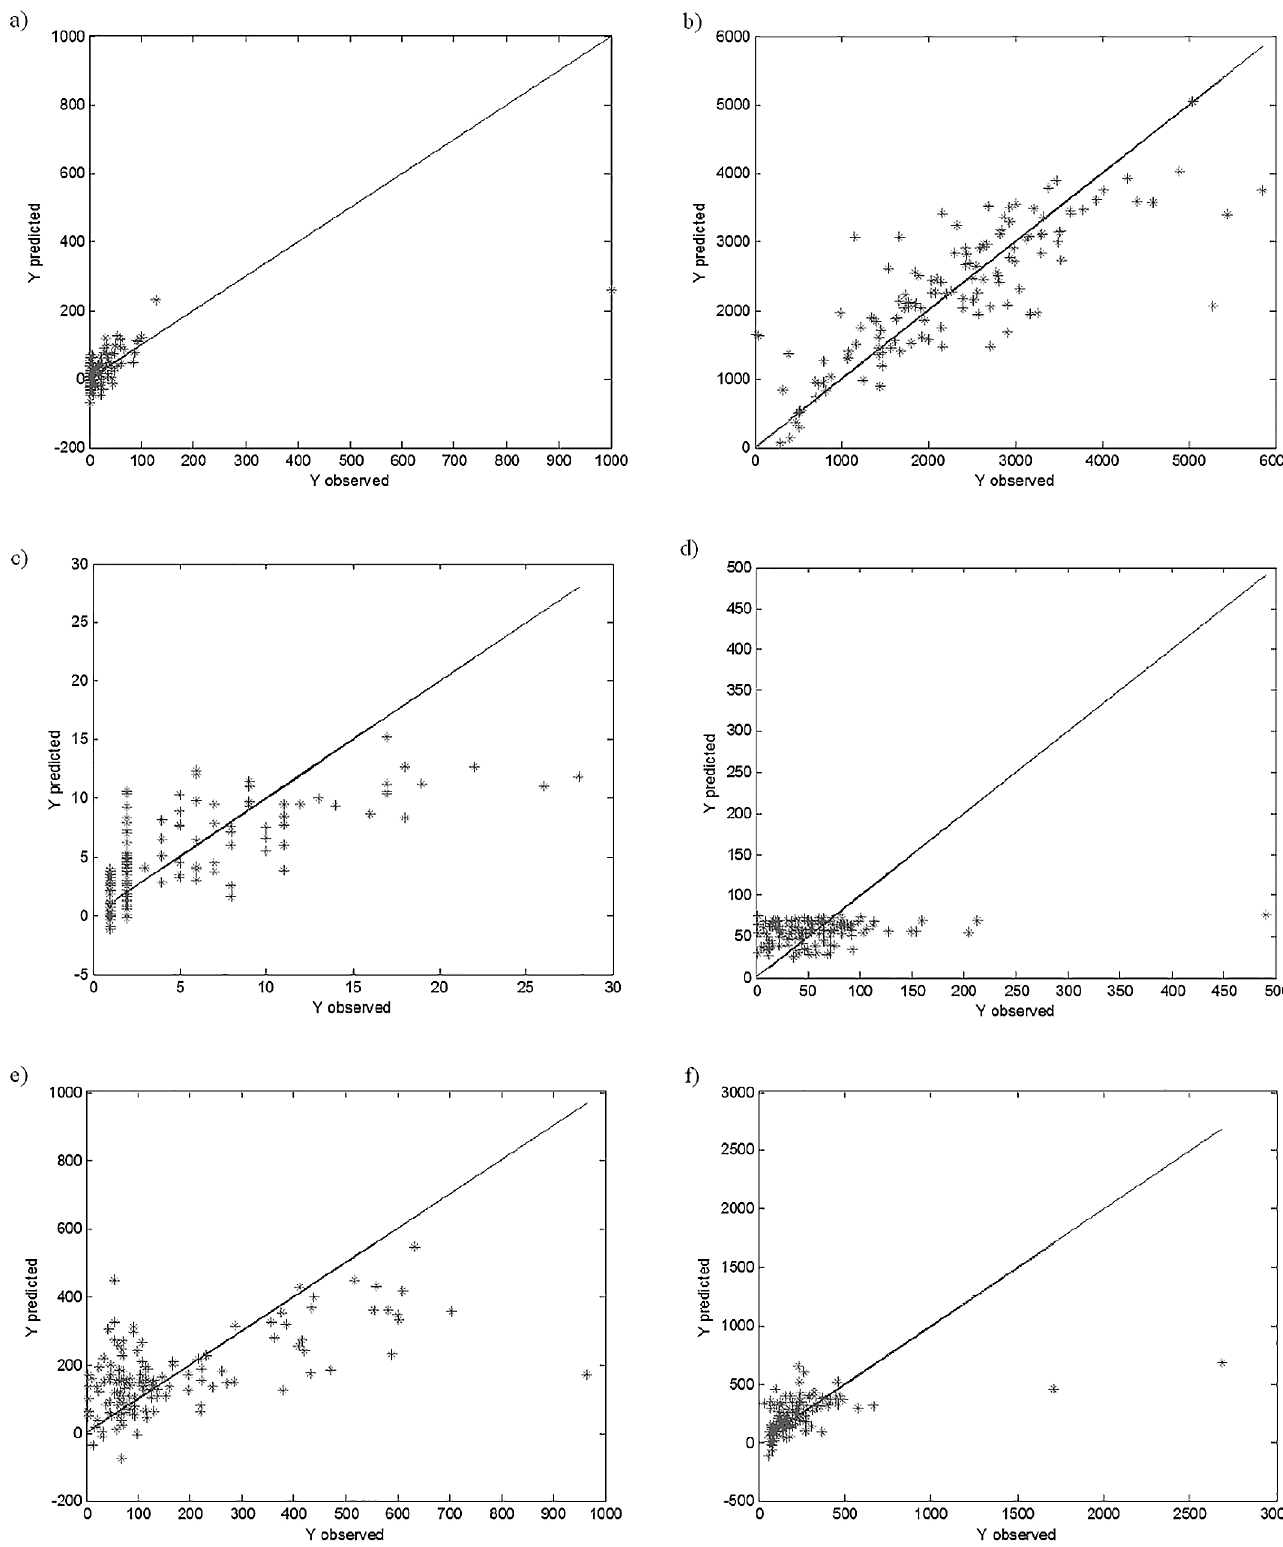
Fig 2. PLS models of trace elements concentrations: (a) As, (b) Ba, (c) Cd, (d) Co, (e) Cr, (f) Cu, (g) Mn, (h) Ni, (i) Pb, (j) Rb, (k) Sr, (l) V and (m) Zn in μ g/g, based on the parameters specified in Table 1. doi:10.1371/journal.pone.0159265.g002 PLOS ONE | DOI:10.1371/journal.pone.0159265 July 20,